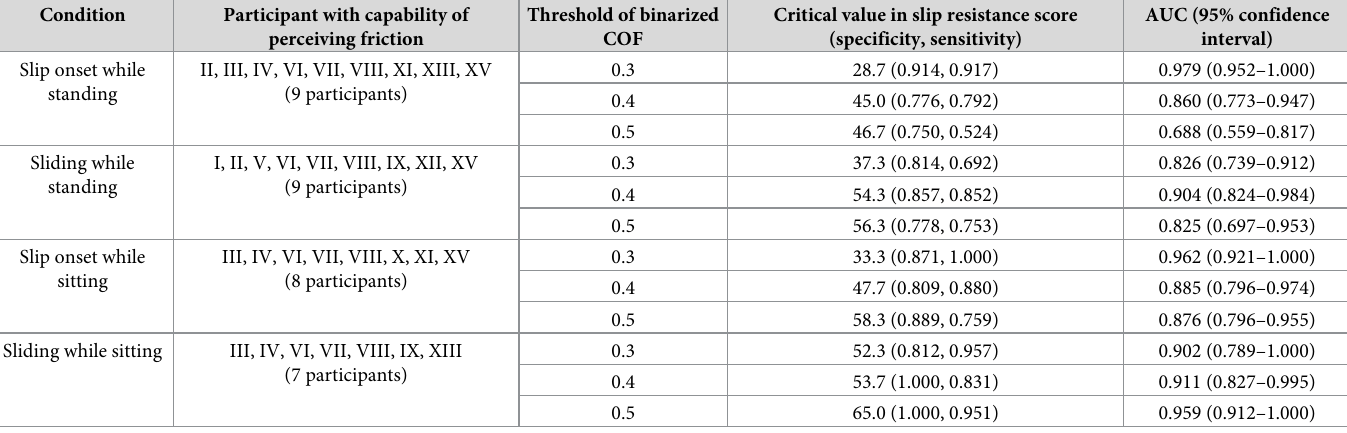
Table 7. Details of ROC analysis by changing threshold of binarized COF from 0.3 to 0.5.